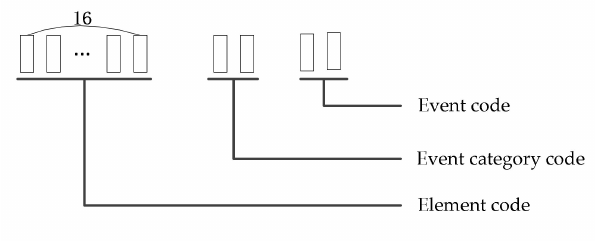
Figure 6. The code structure of grid events in the train operation